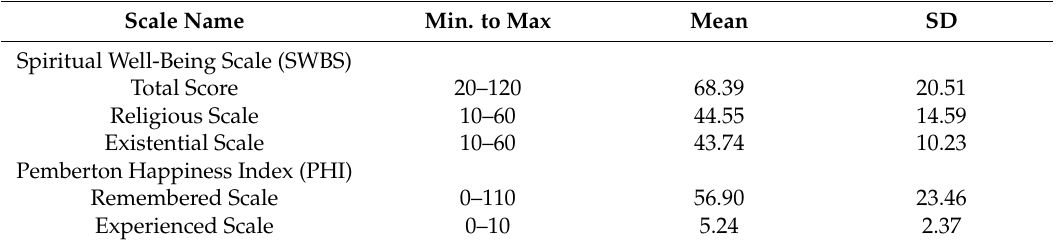
Table 2. Summary of Spiritual Well-Being (SWBS) and Pemberton Happiness Index (PHI) Scales.